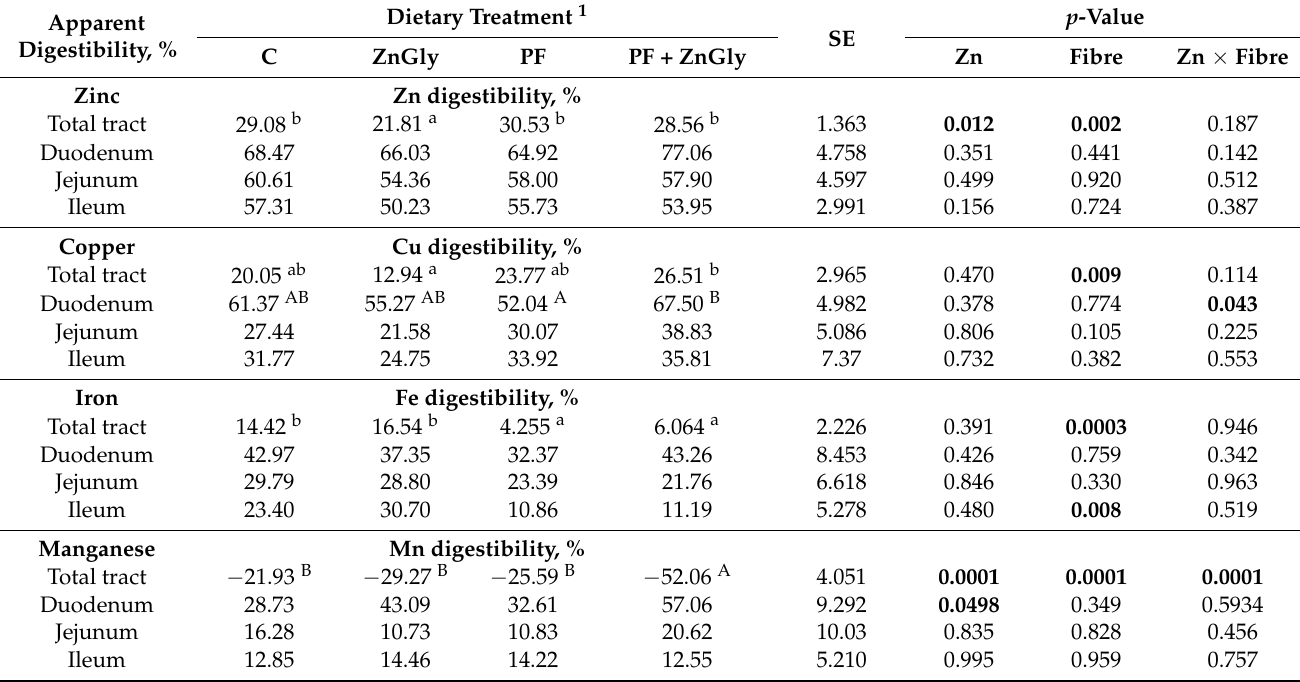
Table 2. Apparent digestibility of Zn, Cu, Fe and Mn in the small intestine and total tract of piglets fed diets supplemented with zinc and fibre from different